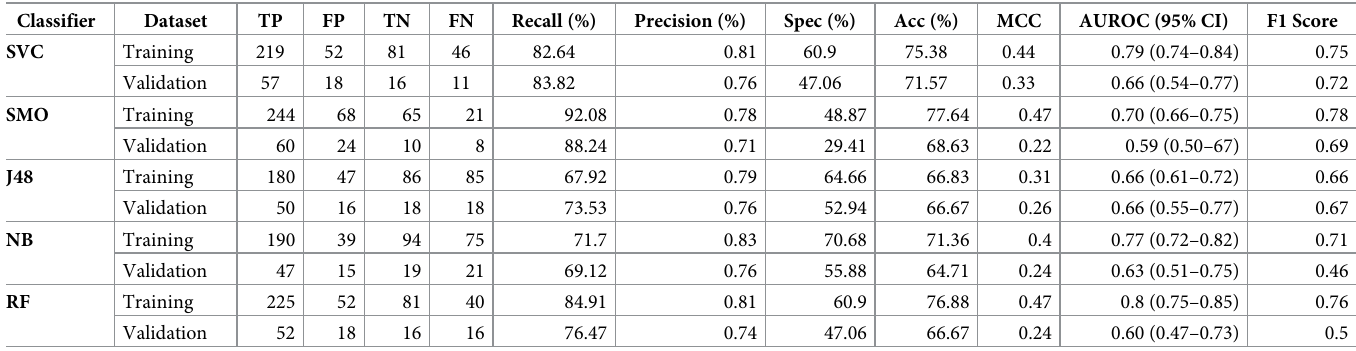
TP: True Positive; FP: False Positive; TN: True Negative; FN: False Negative; Spec: Specificity; Acc: Accuracy; MCC: Matthews Correlation Coefficient; AUROC: